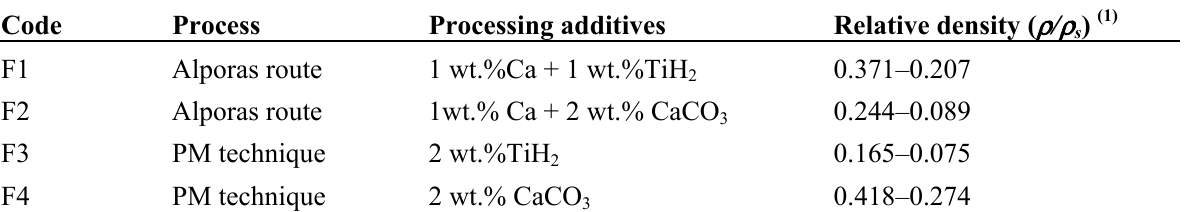
Table 5. Characteristics for different kinds of